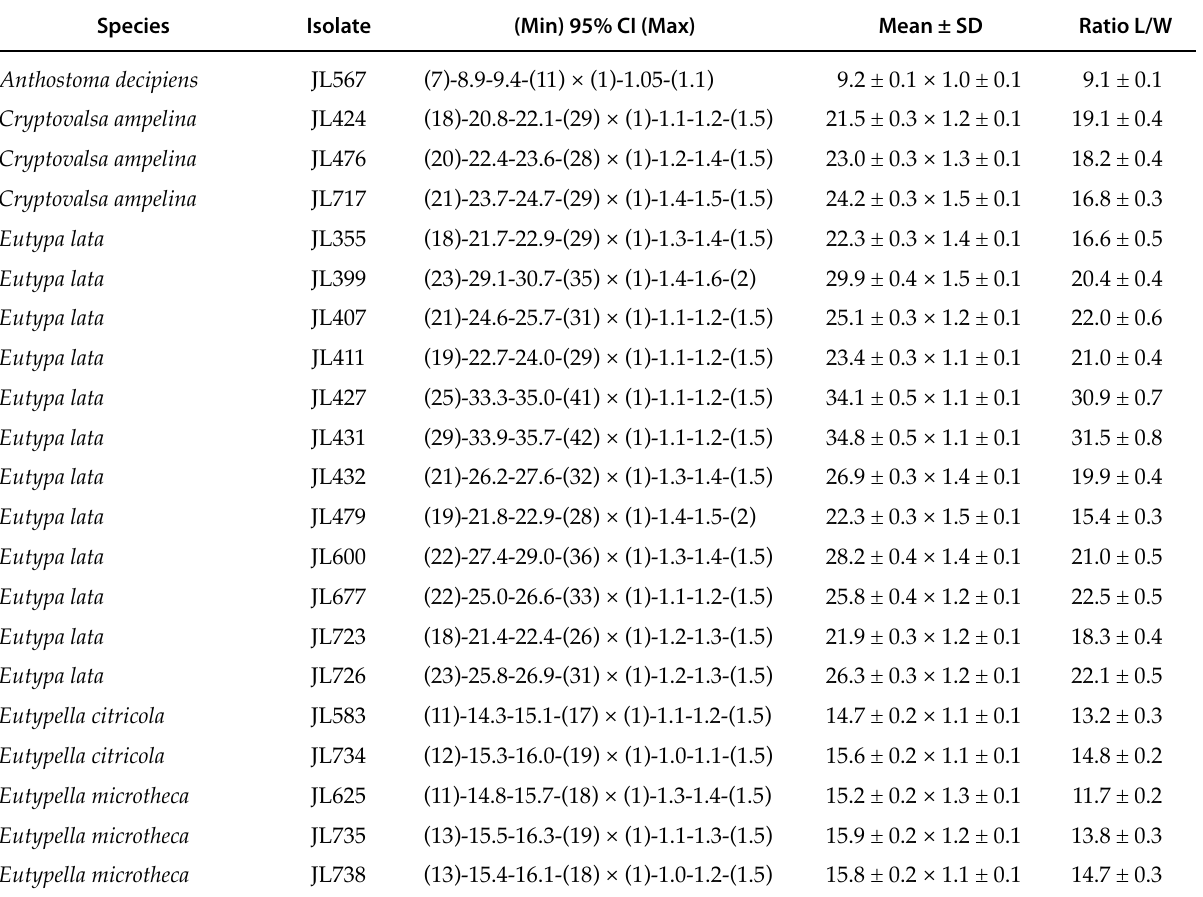
Table 3. Measurements of conidia from Diatrypaceae species isolated from grapevine in